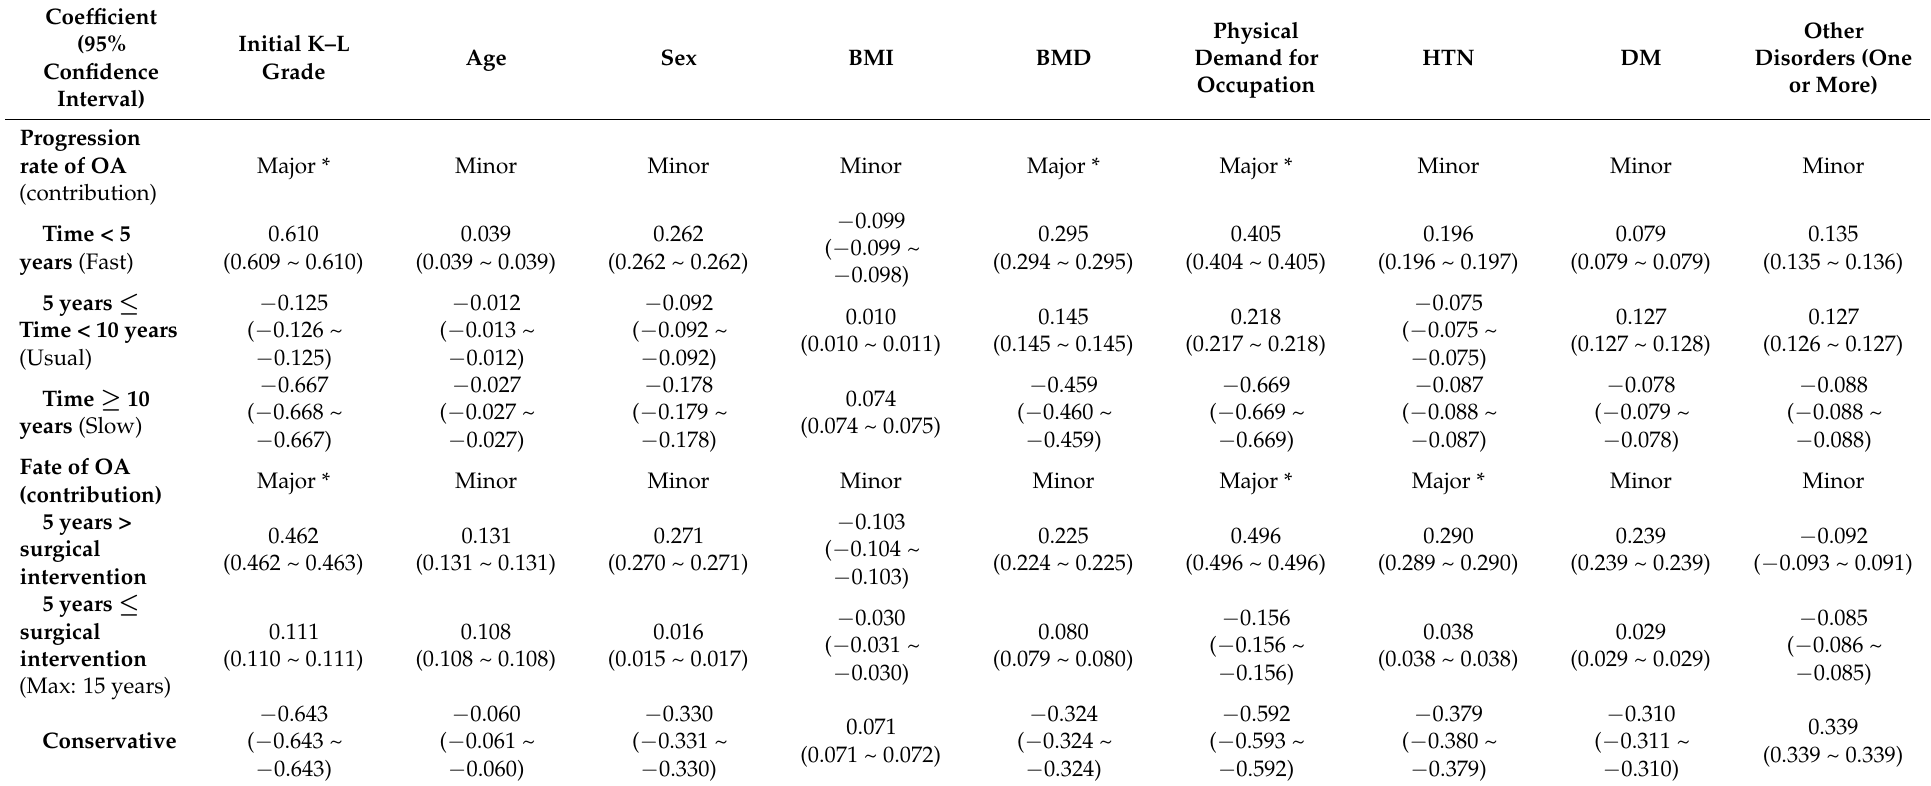
Table 5. Comparison of effect of each